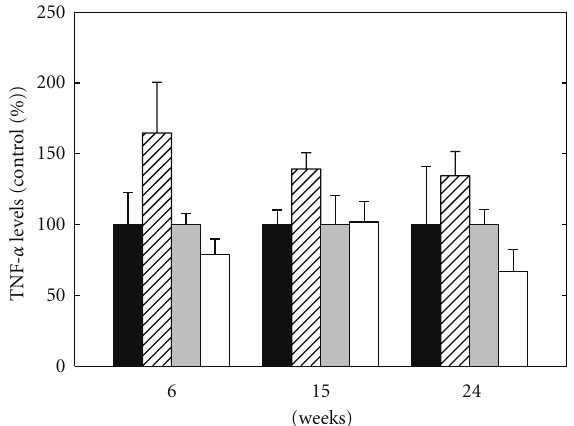
Figure 3: Secreted IL-10 levels of adjuvant mice (black bars) and eAPS mice (upward diagonal bars) versus cytosolic IL-10 levels of adjuvant mice (grey bars) and eAPS mice (white bars). The average of IL-10 level of the adjuvant control group was defined as 100%, and the results expressed as percentage of control group at the same time point. Results are presented as the mean ±